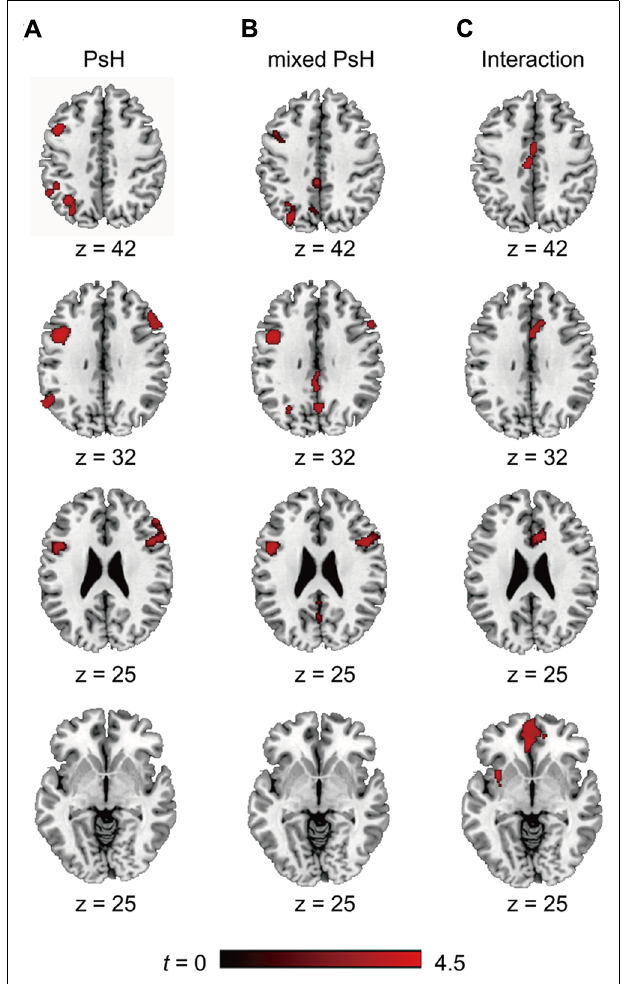
FIGURE 2 |The activated brain areas in different contrasts, PsH = pseudohomophone. (A) Significant clusters as revealed by “PsH > Controls”; (B) Significant clusters as revealed by “mixed PsH > Controls”; (C) Significant clusters as revealed “(mixed PsH > Controls) > (pure PsH >